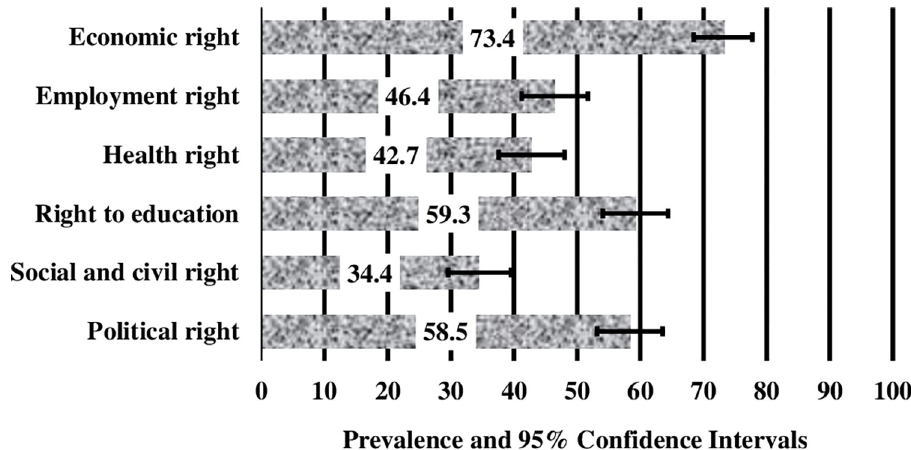
Fig 1. Prevalence of six human rights violations of Bangladeshi Hijras. Error bars represent 95% confidence